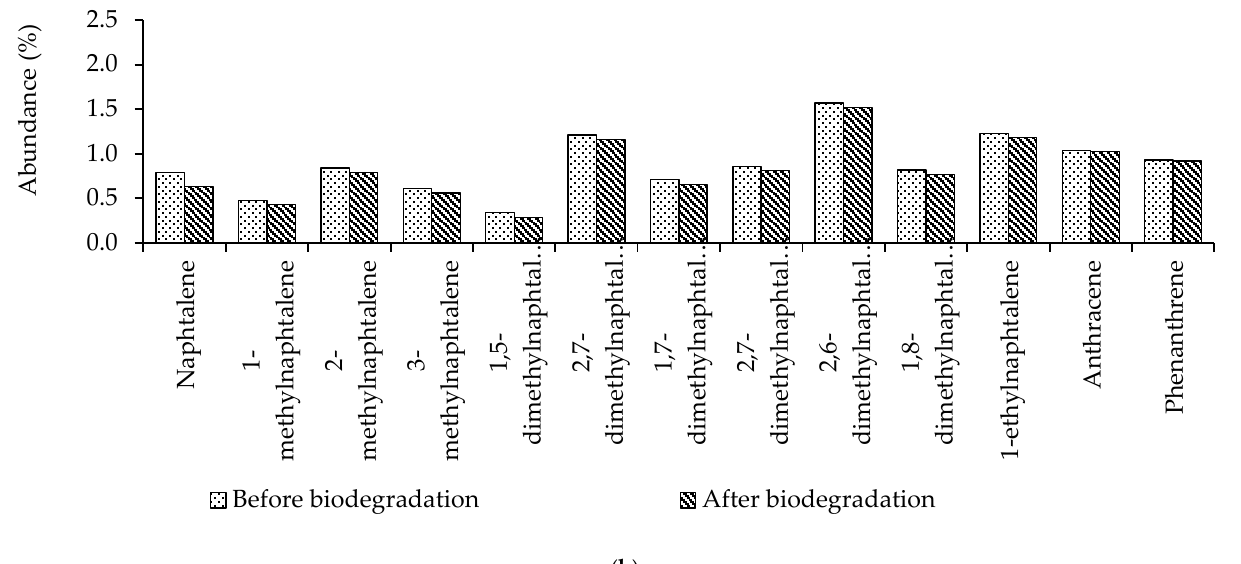
Figure 5. Content change of ( a ) aromatic compounds and ( b ) naphthenic compounds found in crude oil before and after biodegradation from GC-MS analysis. Benzene, toluene, and xylene (BTX compounds) are under detection limit after biodegradation.